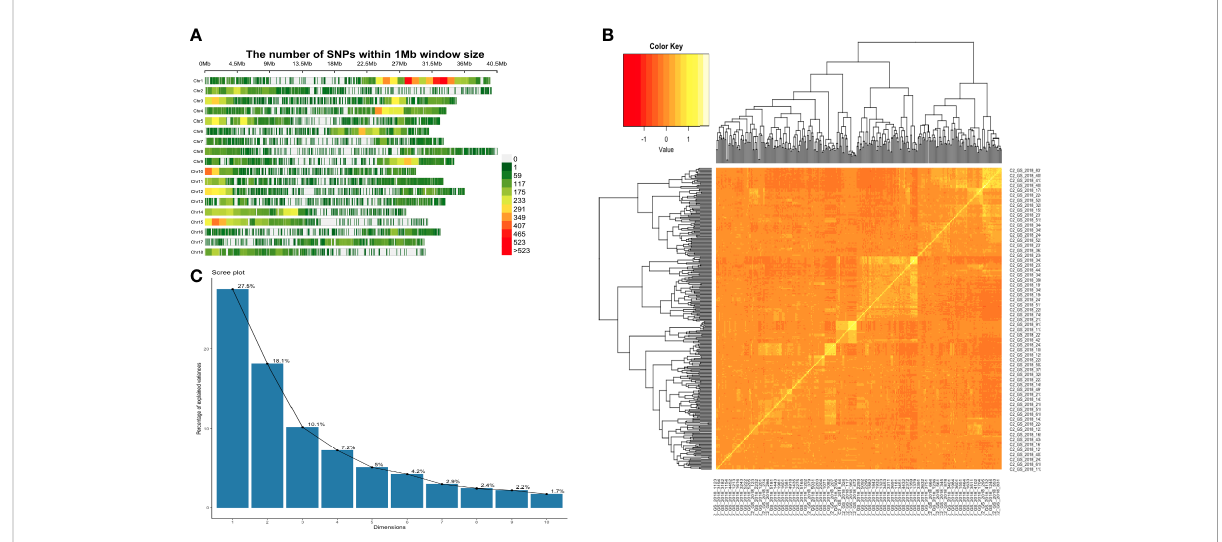
FIGURE 1 (A) Distribution of SNP markers across the 18 chromosomes for genotyped clones in the C2 population. The graph represents the number of SNPs within a 1 mega base window on all the 18 chromosomes in cassava: (B) Heatmap showing pairwise genomic relationship matrix: (C) The proportion of genetic variation explained by the fi rst 10 principal components and 302 cassava clones that were in two years and two